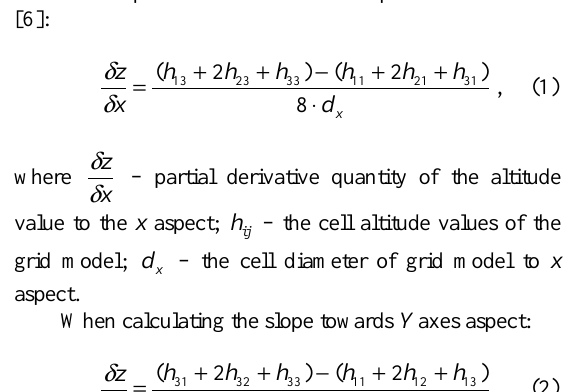
Table 1. Coding of slope values in slope model